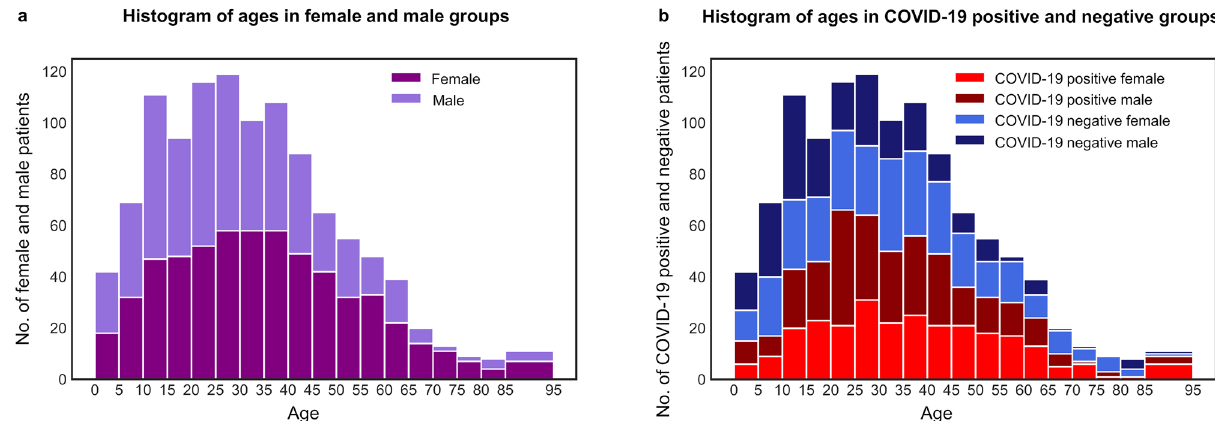
Figure 2. Patient histograms. The analyzed dataset contained 1116 separate nasopharyngeal swab samples from 592 female (of whom 266 COVID-19 positive and 326 COVID-19 negative) and 524 male (of whom 292 COVID-19 positive and 232 COVID-19 negative) patients with ages between 0 and 94 years (mean ± standard deviation, 32 years ± 19 years). The terms female and male refers to the biological sex. ( a ) Histogram describing distribution of female and male patients with different ages in analyzed dataset. ( b ) Histogram describing COVID-19 disease distribution of patients in female and male groups with different ages.